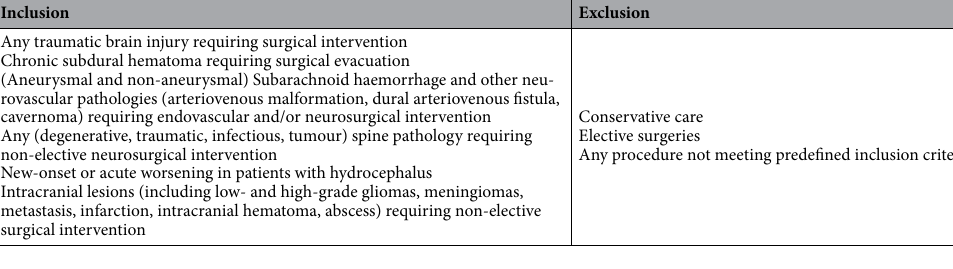
Table 1. Inclusion and exclusion